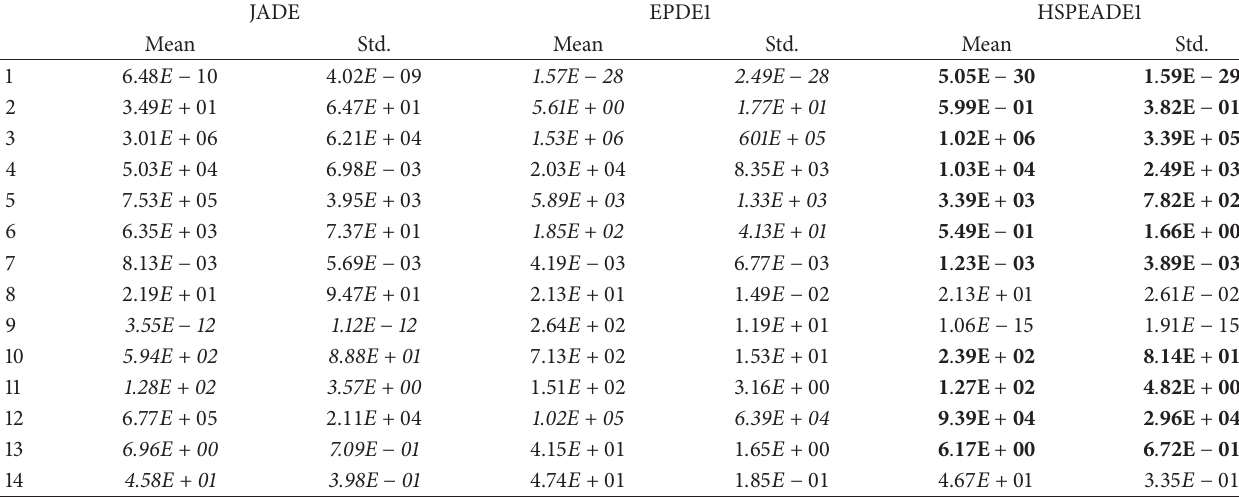
Table 3: Performance of JADE, EPDE1, and HSEPDE1 on 100D problems.